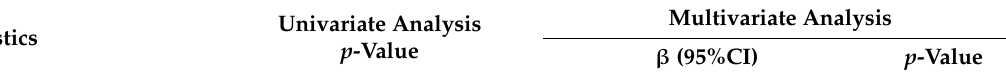
Table 3. Linear regression analysis of global health status in the patients with HCC.